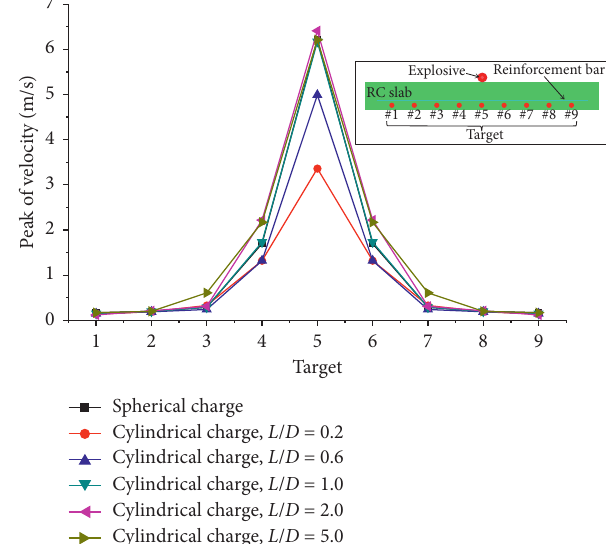
0.2Spherical charge Cylindrical charge, L / D = Cylindrical charge, L / D = 0.6 Cylindrical charge, L / D = 1.0 Cylindrical charge, L / D = 2.0 Cylindrical charge, L / D = 5.0 Figure 21: Comparison of peak pressures at targets from the spherical and cylindrical